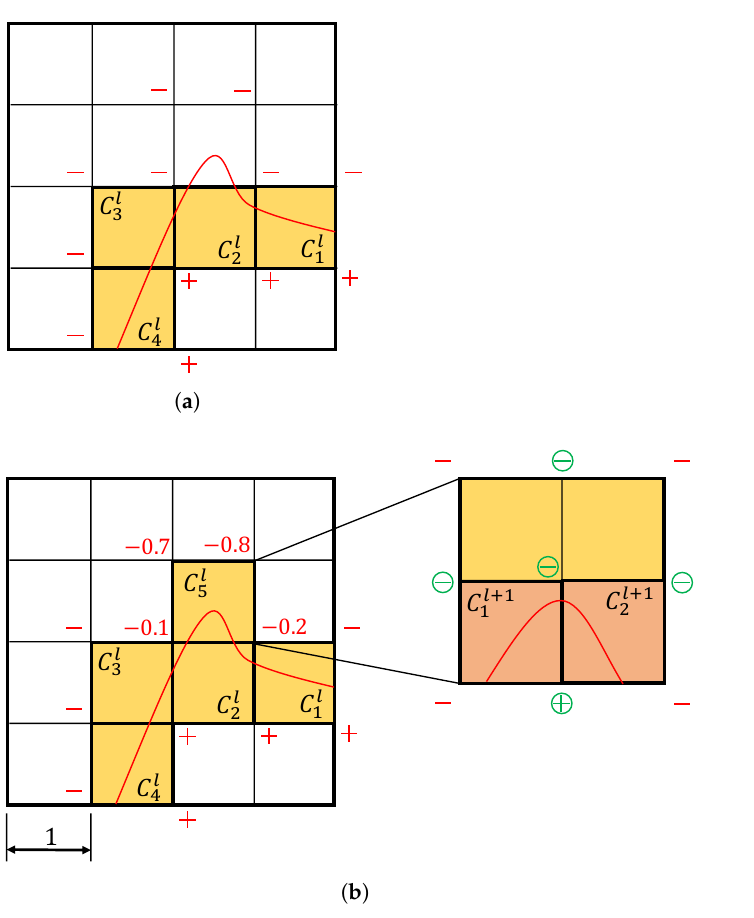
Figure 15. ( a ) Determination of level l cut cells using the sign-based criterion. A cut cell is missed due to the small feature size. ( b ) Determination of level l cut cells using the distance-based criterion, followed by sign-based subdivision to generate the level l + 1 cut cells. For a cell size d cell = 1, the distances of the C l vertices to the boundary are annotated in the 5